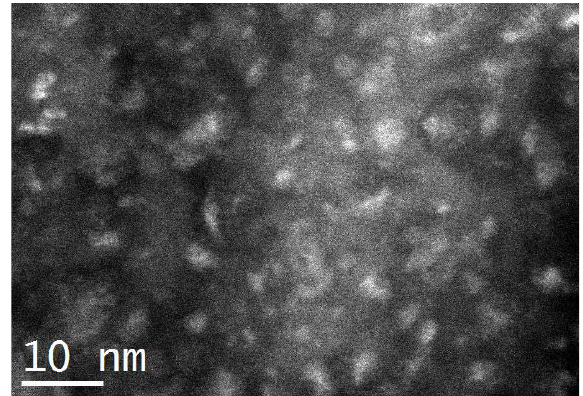
Fig. 1: Irradiation-induced nanopatterning in Cu Ag thin film irradiated with 1.8 MeV 90 10 Kr ions at variable temperatures [2].